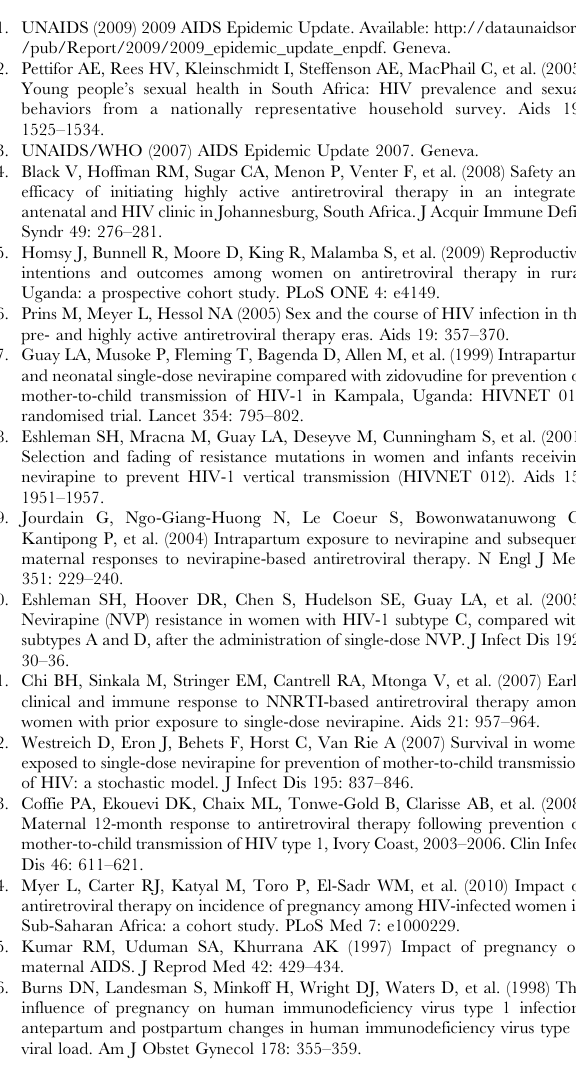
Table S1 Main and sensitivity analyses for